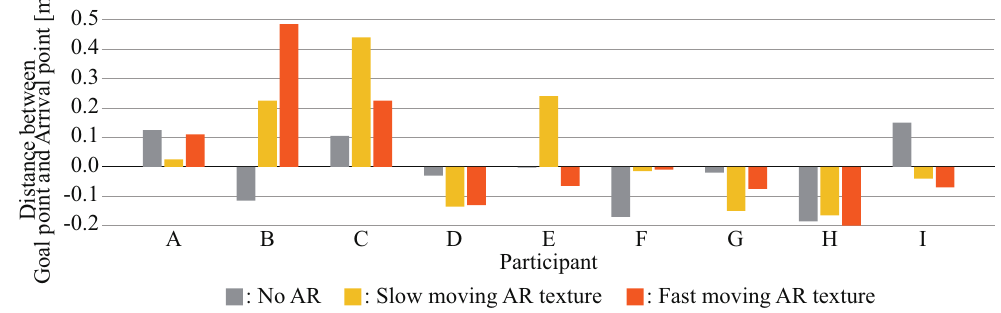
Figure 24. Results of individual distance between the goal point and the arrival point.